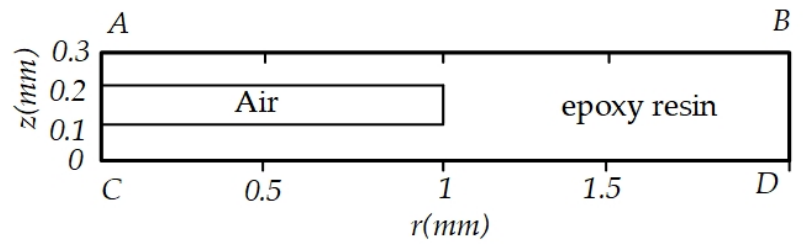
Figure 2. The model of simulation.